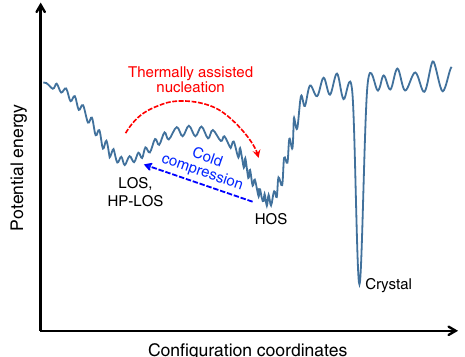
Fig. 5 Schematic diagram of the potential energy landscape. The x axis represents all con fi guration coordinates. The three states labeled LOS/HP- LOS, HOS, and crystal differ in the shape and depth of their potential energy wells/megabasins. The thermal-driven transition from LOS to HOS and the pressure-driven transition from HOS back to LOS (HP-LOS) are indicated by the red and blue dashed arrows, respectively. Please note that the real PEL may be very complex and the transition path between different states is not necessarily limited in the plane of the